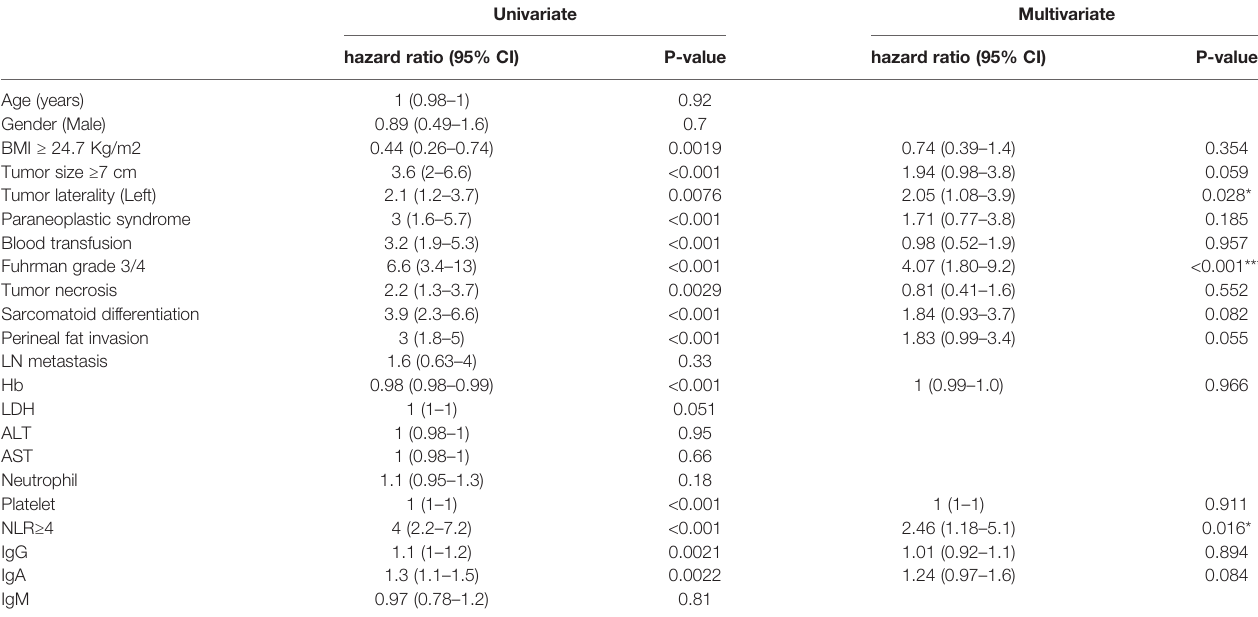
TABLE 1 | Univariate and multivariable Cox proportional hazard regression analysis of CSS in our clinical cohort. Univariate Multivariate hazard ratio (95%